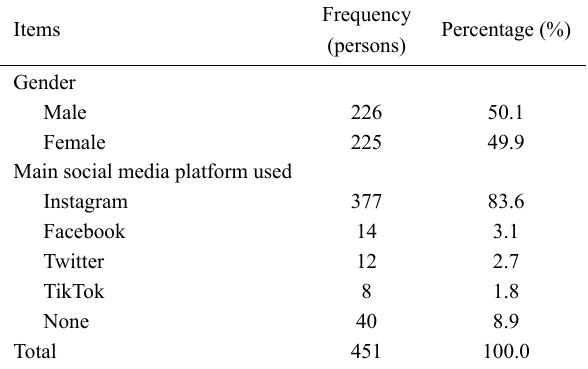
Table 1. General characteristics of